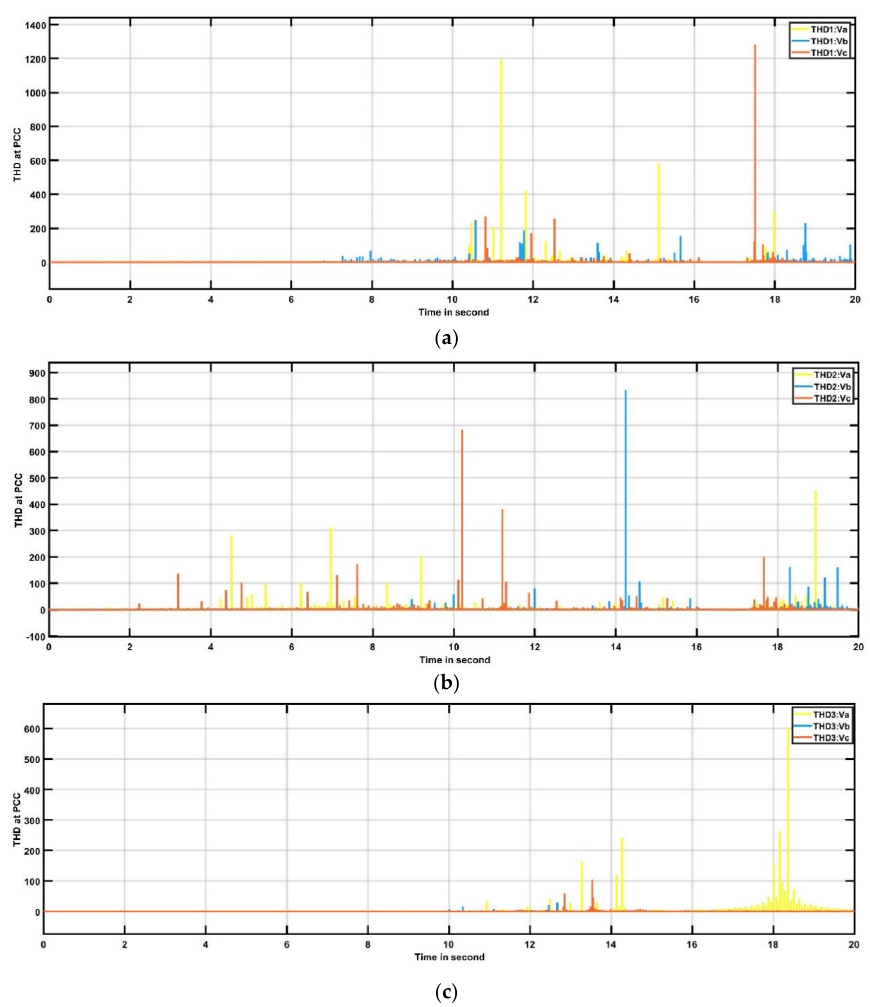
Figure 19. Harmonic spectra of voltage in PCC for ( a ) no control, ( b ) predictor controller, and ( c ) fuzzy controller methods.